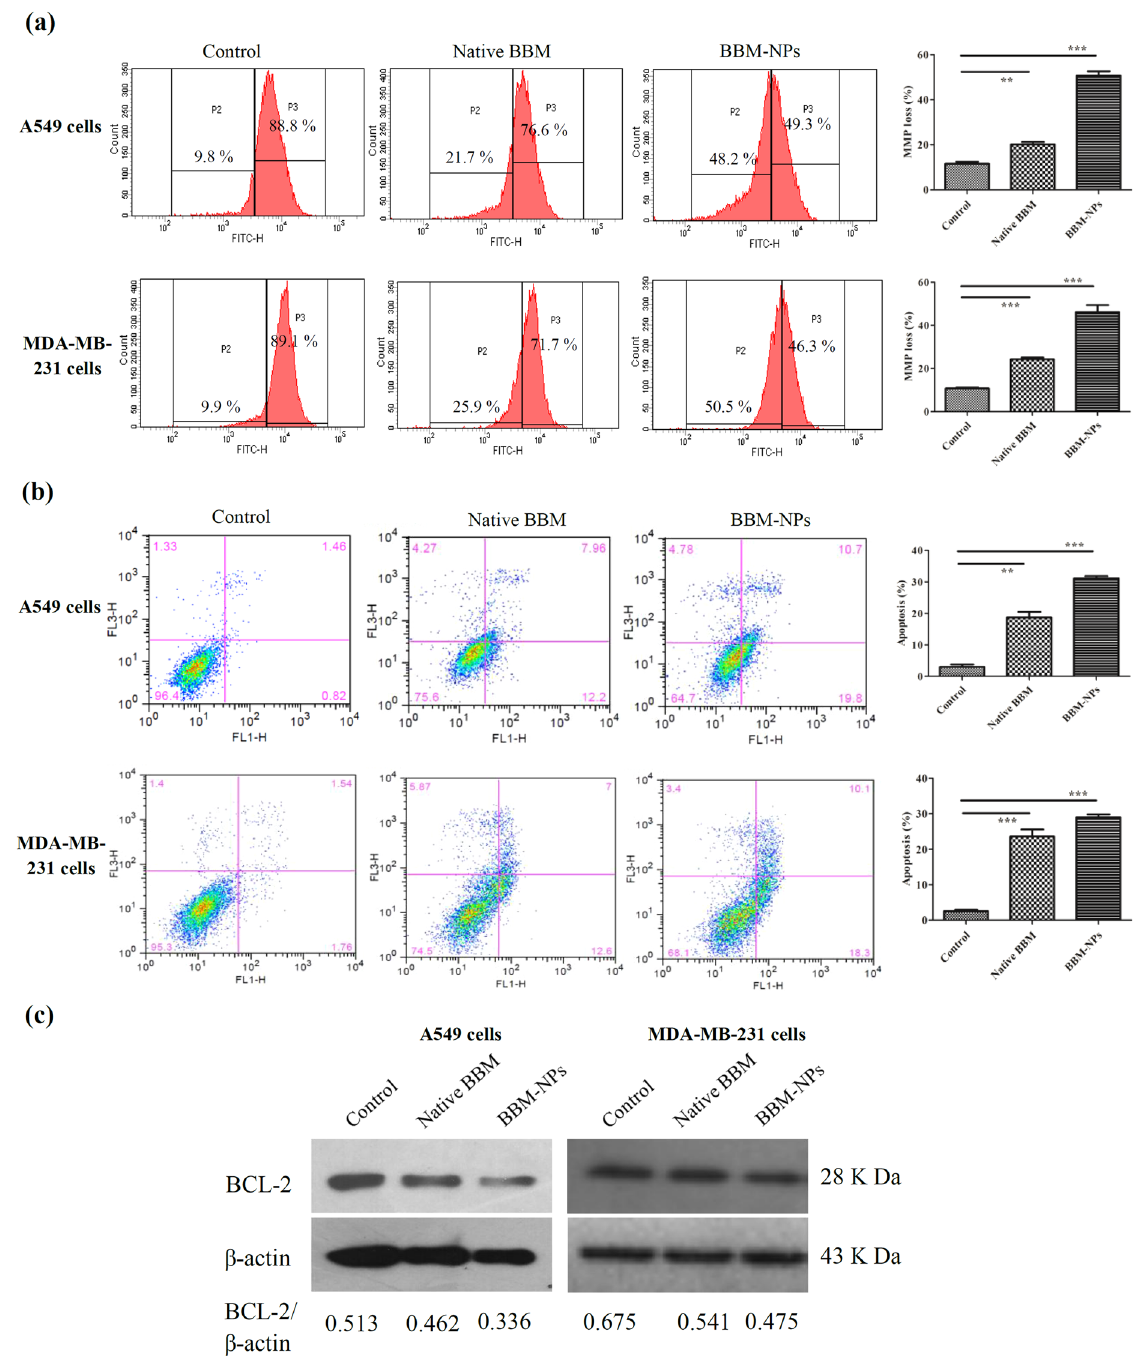
Figure 6. Analysis of mitochondrial function and apoptosis by flow cytometry and expression of anti-apoptotic protein BCL-2 by western blot analysis. ( a ) A549 and MDA-MB-231 cells were treated with Native BBM and BBM-NPs (25 µ M) for 48 hrs. Cells associated with mitochondrial function using Rhodamine 123 was analyzed by flow cytometry. Values are as mean ± SEM, n = 3, ** p < 0.001, *** p < 0.0001 for Native BBM and BBM- NPs vs. control. ( b ) Induction of apoptosis in A549 and MDA-MB-231 cells treated with Native BBM/BBM- NPs (25 µ M) for 48 hrs and percentage of apoptosis (early and late) was measured using Annexin V-FITC by flow cytometry. Values are as mean ± SEM, n = 3, ** p < 0.001, *** p < 0.0001 for Native BBM and BBM-NPs vs. control. ( c ) Western blot analysis of anti-apoptotic protein BCL-2 associated with apoptosis in A549 and MDA-MB-231 cell lines following 25 µ M BBM treatments (Native/NPs) for 48 hrs. β -actin serves as loading